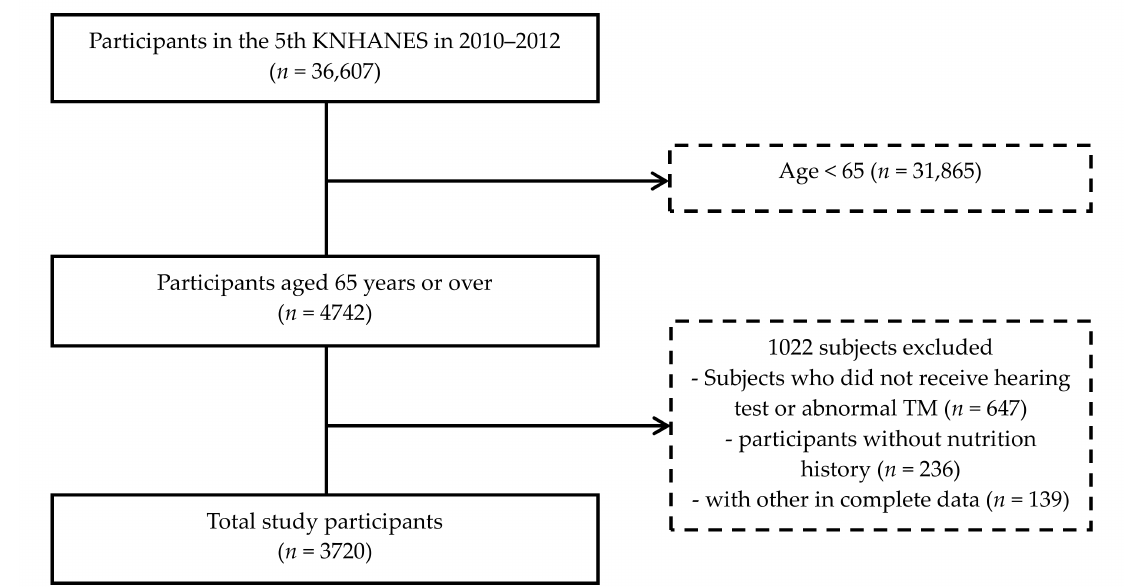
Figure 1. A schematic illustration of participant selection in the present study. TM, tympanic